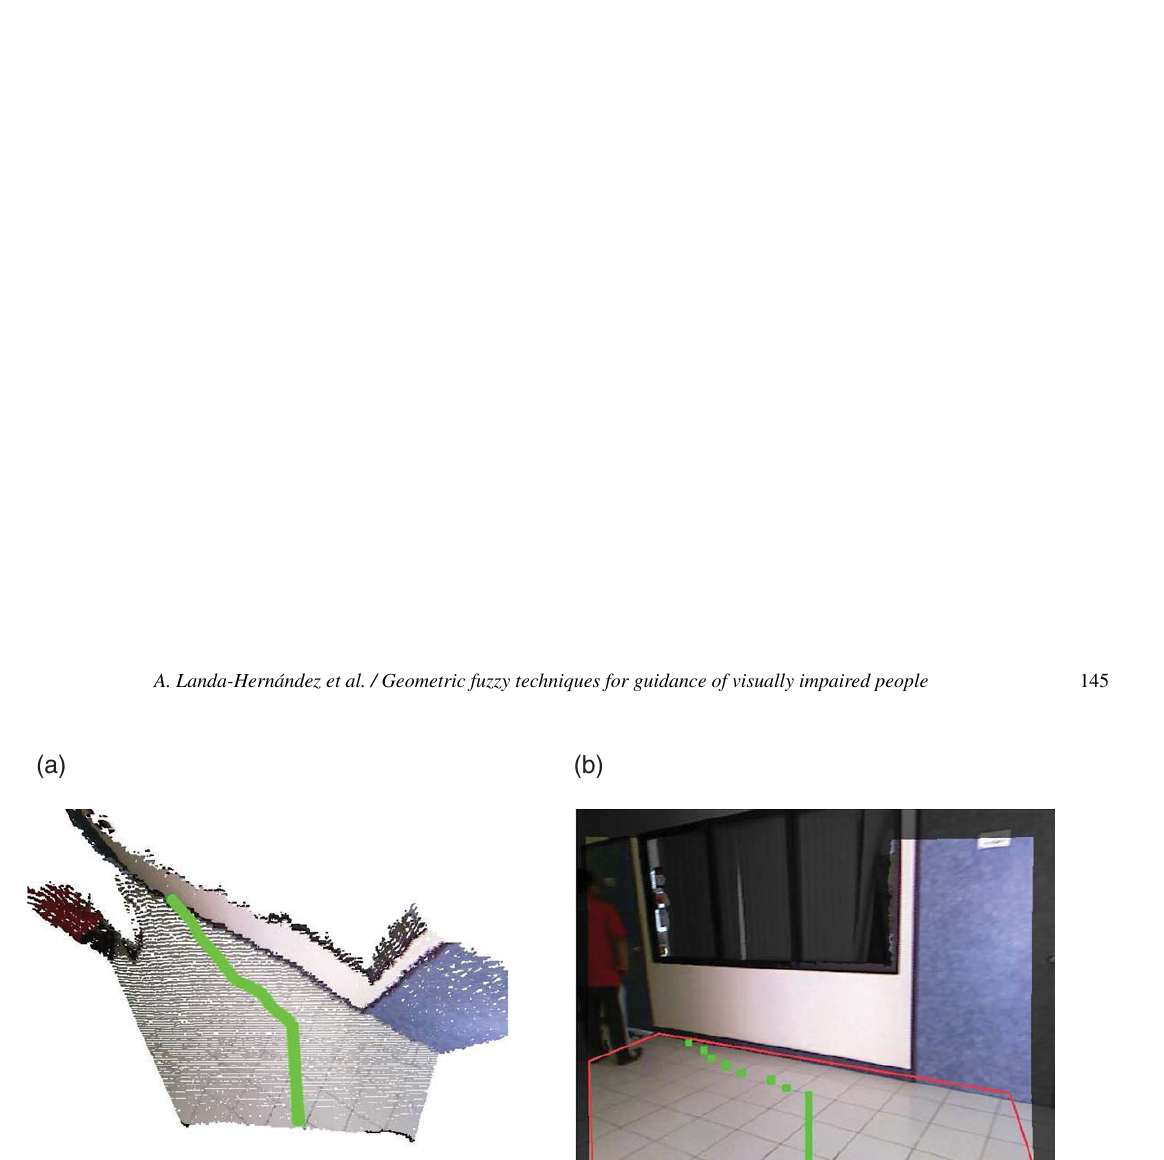
changes and noise on line borders, we are required to average the intersection of N pairs of parallel lines